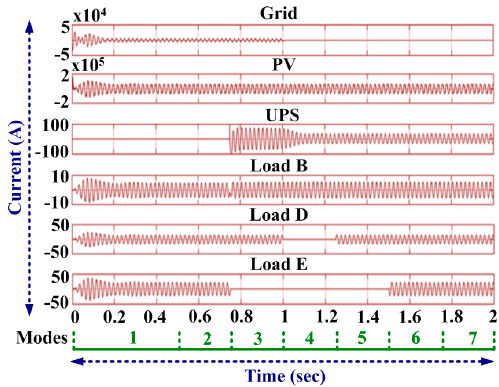
Figure 9. Output current of (top to bottom: grid, PV, UPS, load B, load D, and load E).